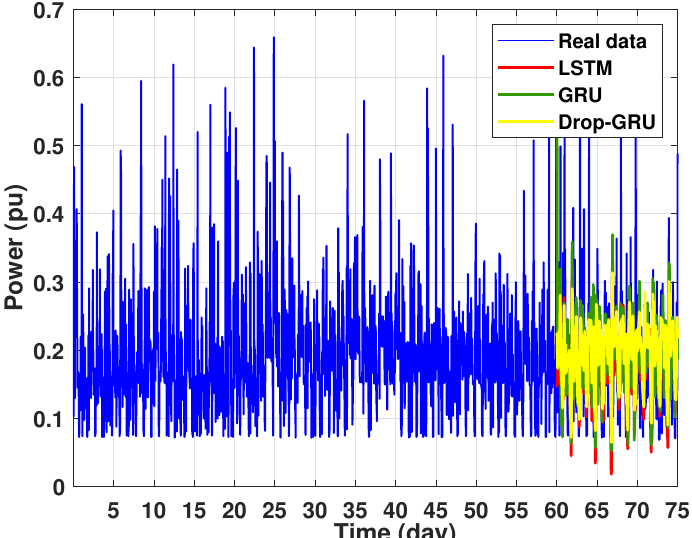
Figure 18. Prediction of 15 days power consumption for the first area.